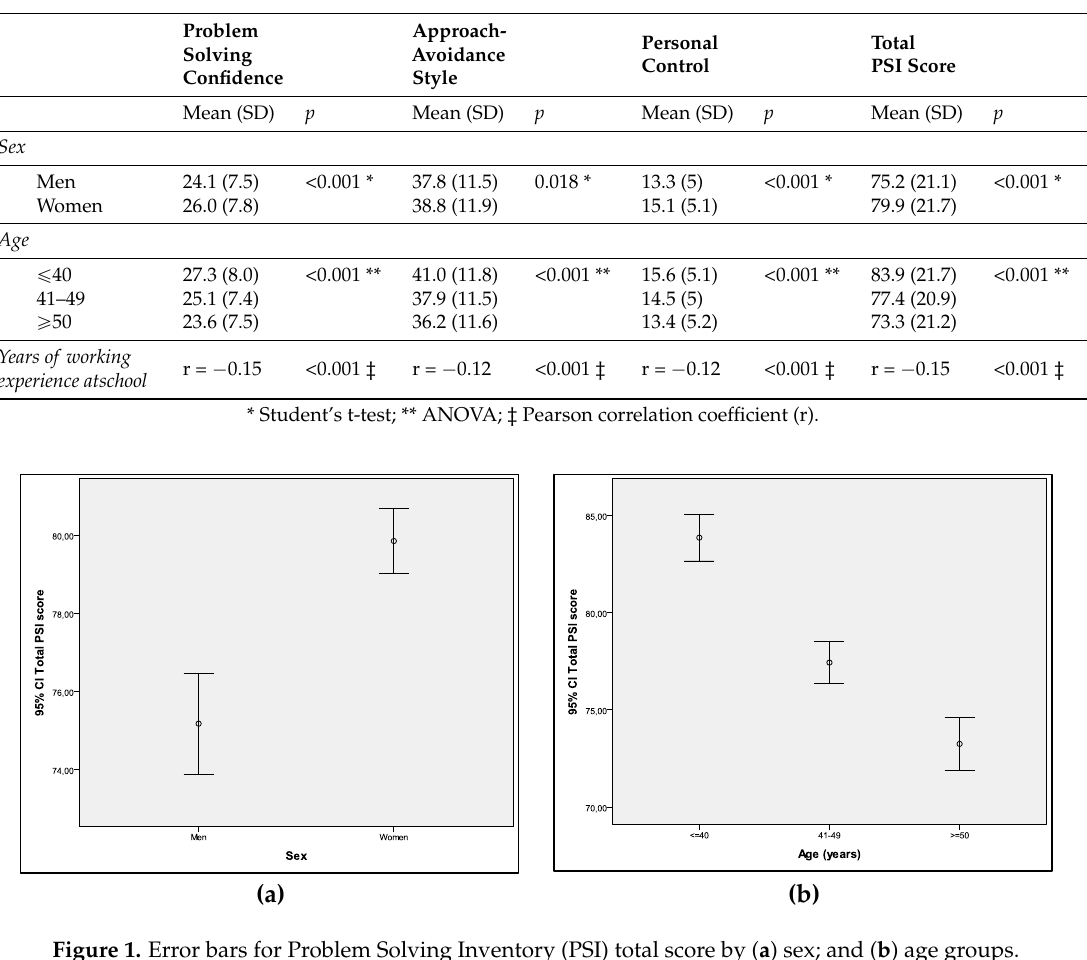
Table 4. Differences in sex, age and years of working experience at school on the Problem Solving Inventory subscales.